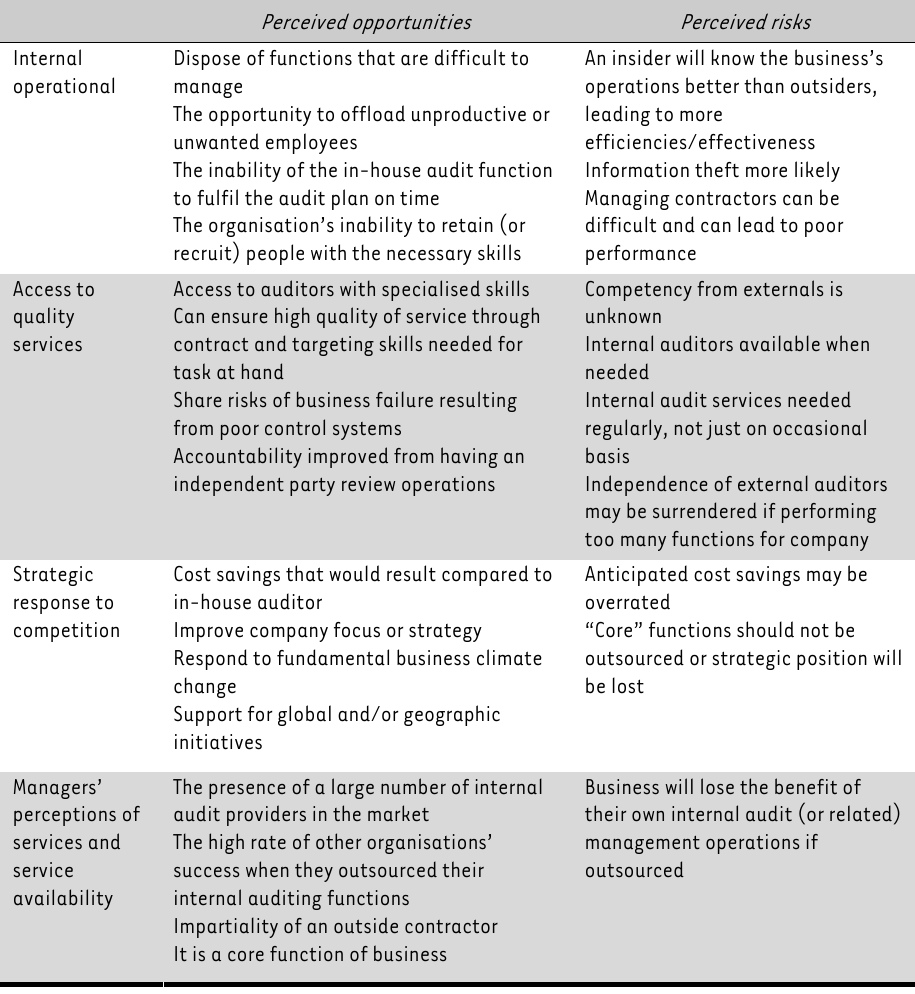
TABLE 2: Rationale for and against outsourcing the Internal Audit Function Perceived opportunities